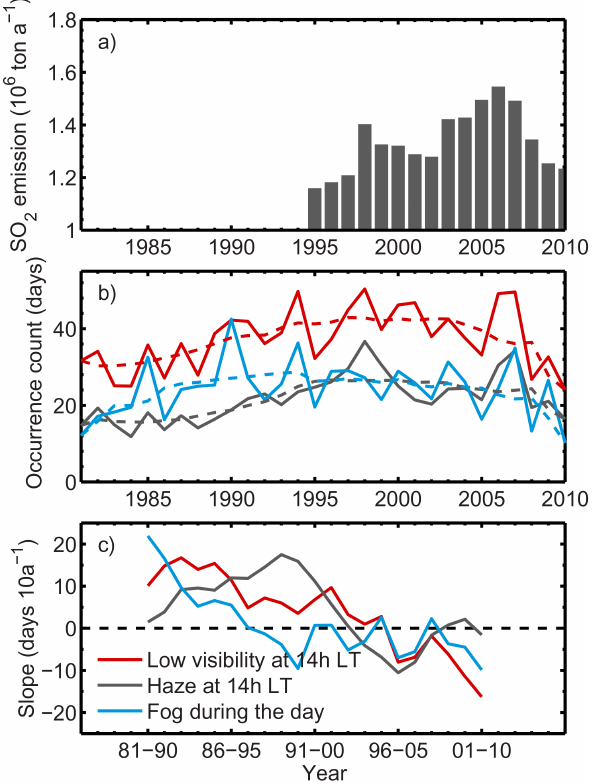
Figure 3. (a) The annual SO 2 emissions in Hebei Province inferred from the China statistical yearbooks (National Bureau of Statistics of China, 1995–2010); (b) the annual (solid lines) and the 10-year moving average (dashed lines) occurrence of low visibility, haze and fog days among the 64 stations during the period 1981–2010; (b) the slope of the linear fits to the 10-year moving averages of low visibility, haze and fog days among the 64 stations during the period